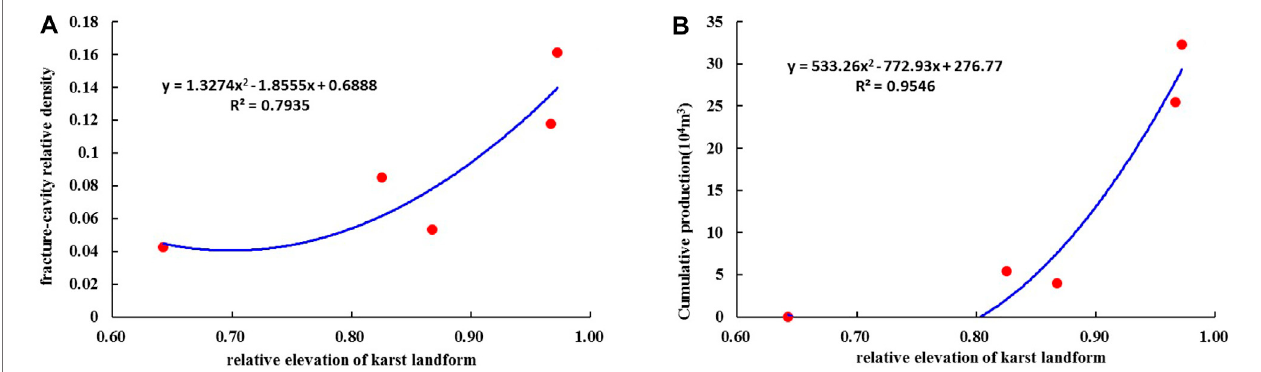
Frontiers in Earth Science |